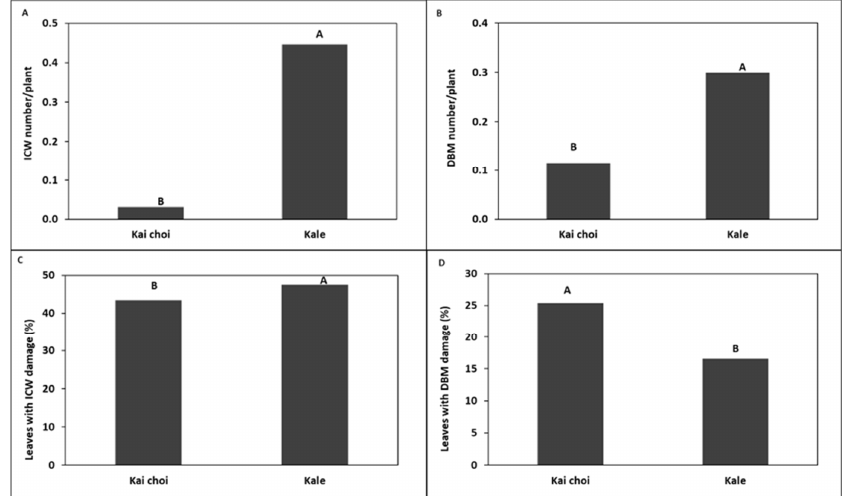
Figure 12. Abundance of ( A ) Imported cabbageworm (ICW) larvae and eggs; ( B ) Diamondback moth (DBM) (larvae and pupae); ( C ) Percentage of ICW leaf damage; ( D ) DBM leaf damage on kai choi and kale in Trial I. Means followed by the same letters in a graph are not different based on analysis of variance. In terms of kale yield in Kale Trial I, ANOVA showed no interaction between trap of cropping and EPN, and no significant effect from EPN applications. Thus, only means of